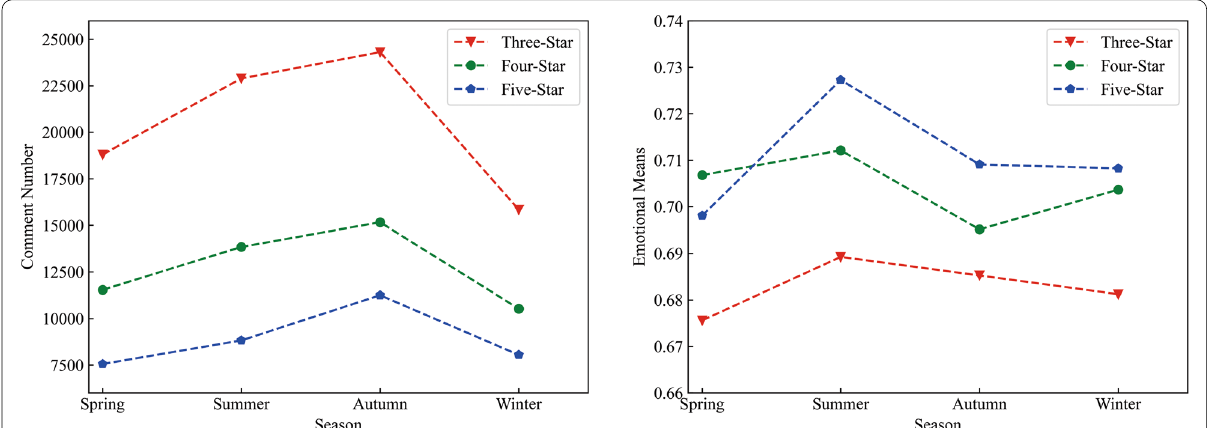
Fig. 4 Seasonal statistics on the number of reviews and mean sentiment values